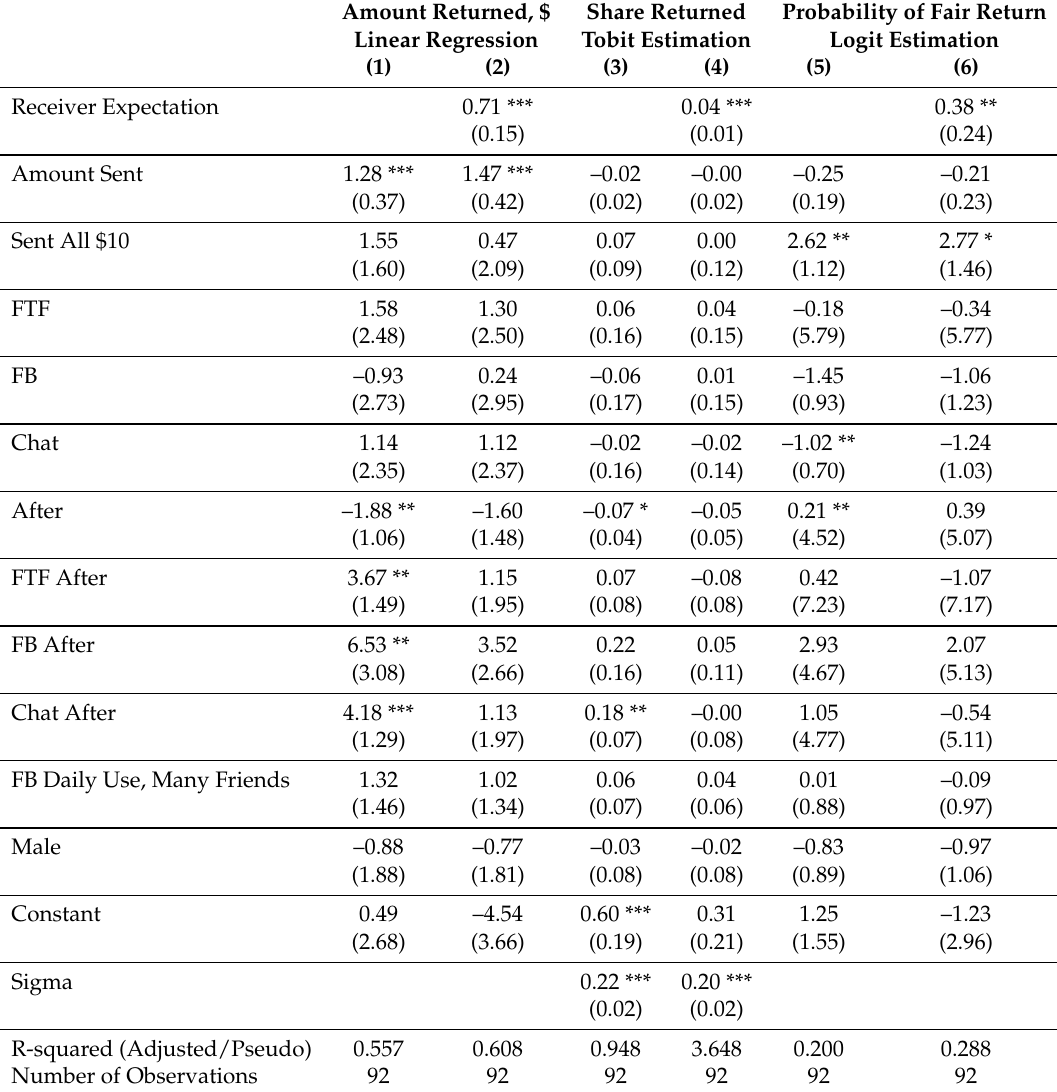
Table 5. Receiver decision: regression